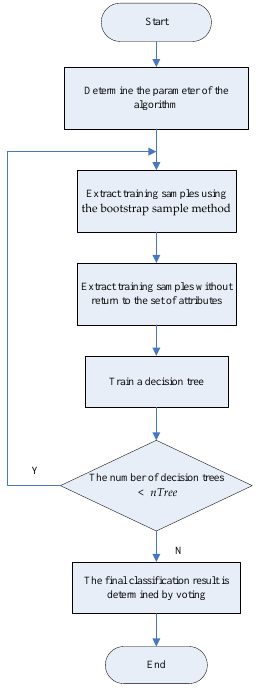
Figure 4. Flow chart of random forest.